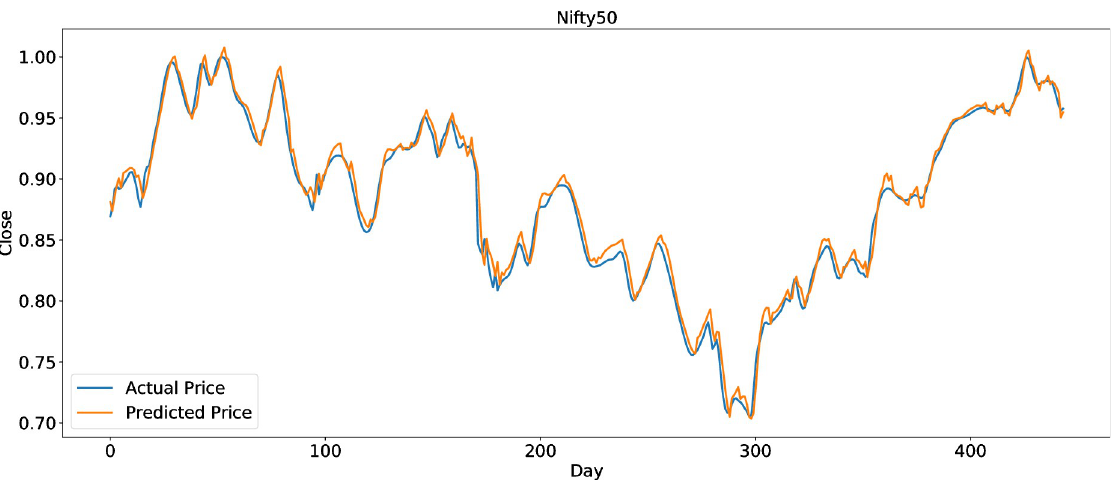
Fig 17. Prediction results of Nifty50 data set.